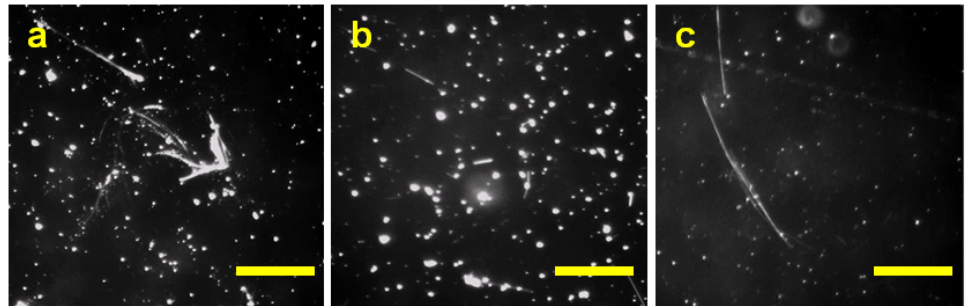
Figure 3. Raw images of ball-mill ground asbestos samples obtained by